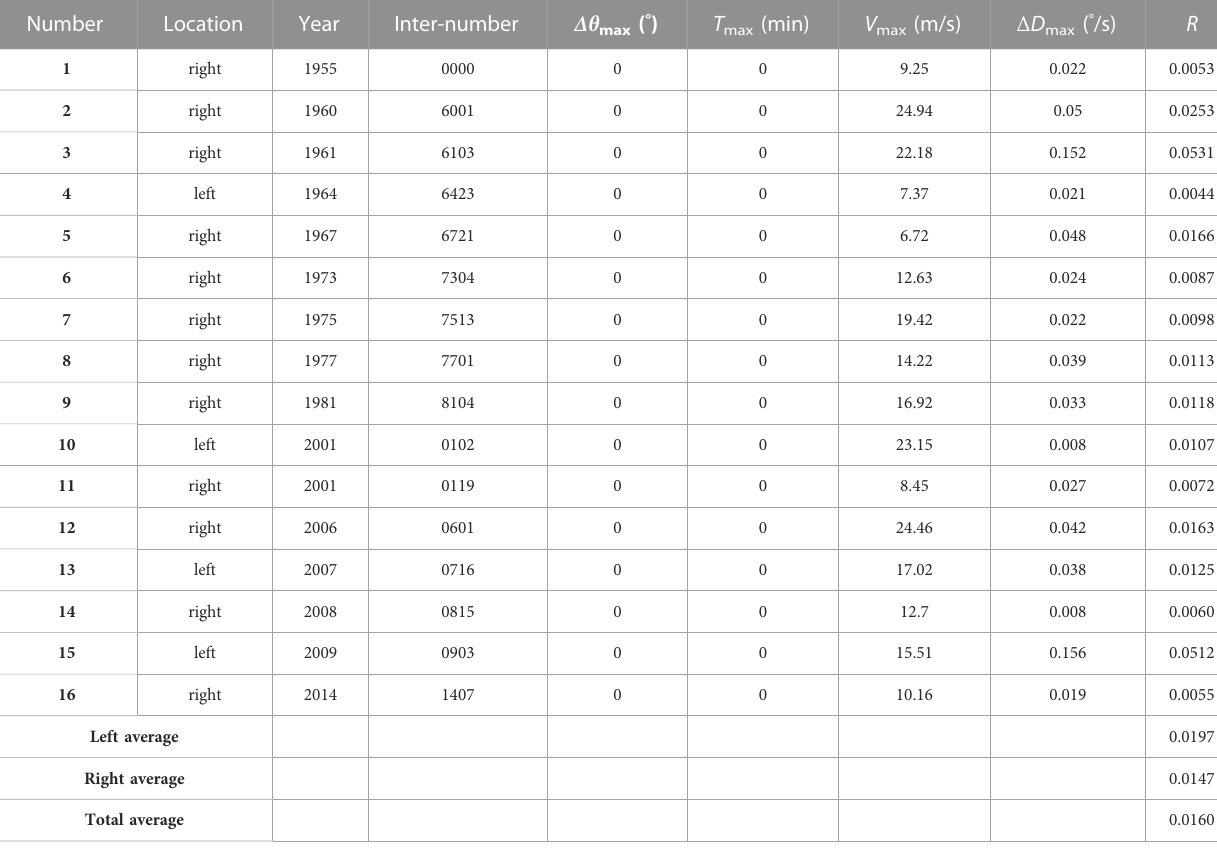
TABLE 9 Composite risk index (from southwest to northeast).